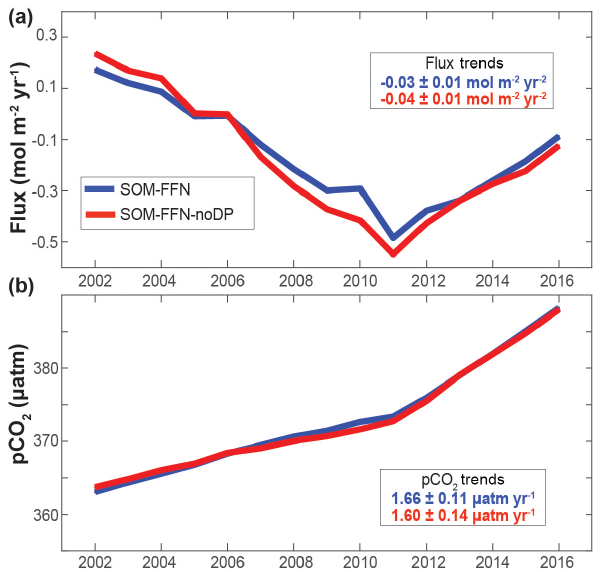
Figure 6. (a) Sea–air CO 2 flux and (b) p CO 2 averaged over the Southern Ocean SPSS biome, from the SOM-FFN p CO 2 product (blue) and that of the SOM-FFN-noDP product created without the inclusion of Drake Passage data (red). Trends and uncertainty values in corresponding